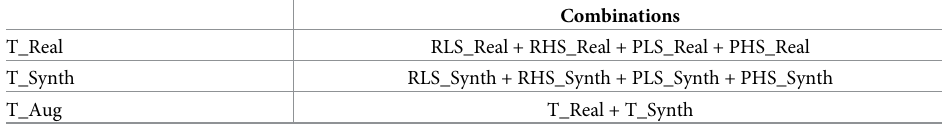
Table 4. Real, synthetic and augmented underwater sonar image